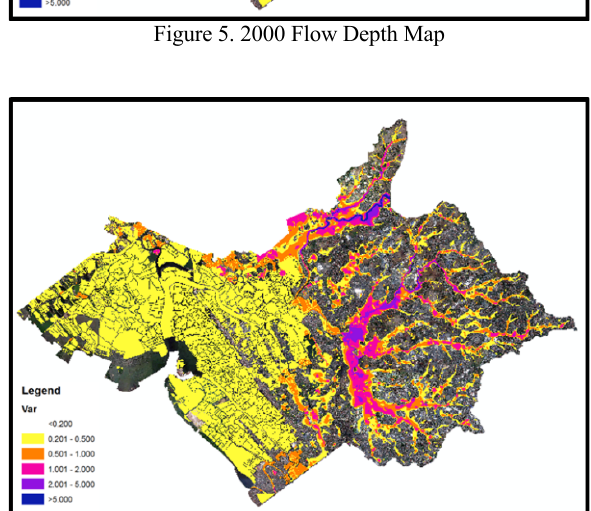
Figure 6. 2020 Flow Depth Map